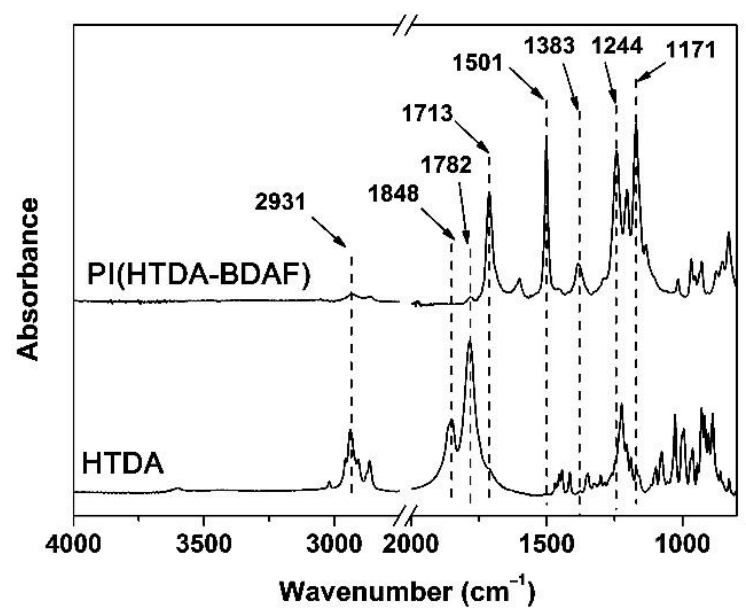
Figure 3. ATR-FTIR spectra of the PI (HTDA-BDAF) and the HTDA dianhydride. Figure 4 depicts the 1 H-NMR spectrum of the PI resin. The absorptions of the protons in the PI were clearly divided into two parts. The absorptions of the aromatic protons (H 13 ~H 16 ) in the BDAF appeared at the downfield area in the spectrum (7.0–7.5 ppm), whereas the aliphatic protons (H 1 ~H 12 ) in the HTDA moiety revealed the absorptions at the upfield region in the spectrum (1.0–3.5 ppm). This is also in good consistency with the theoretical molecular structure of the PI.